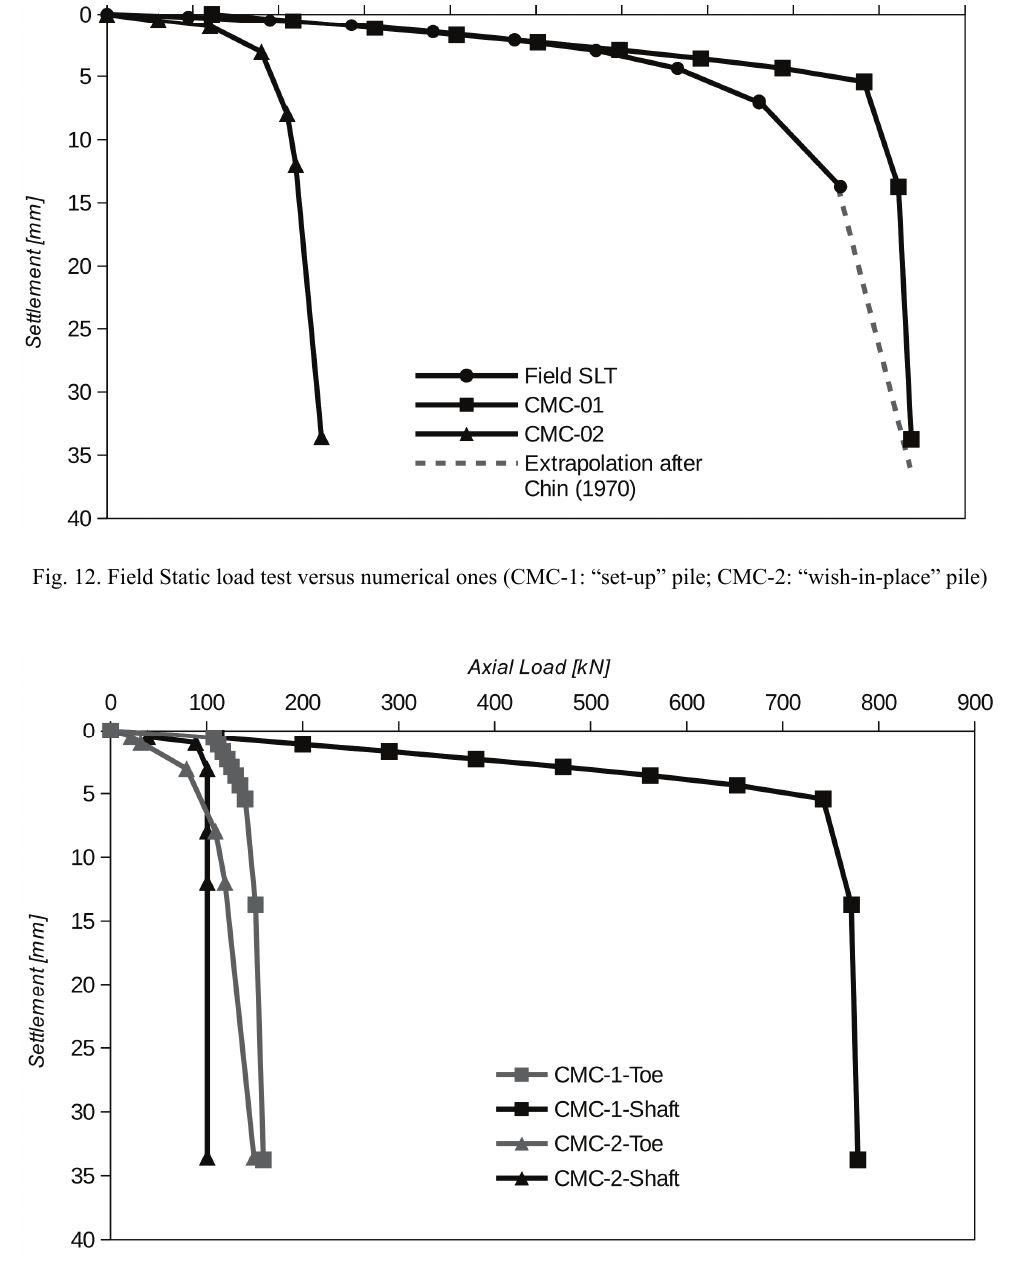
Fig. 13. Toe and shaft capacity obtained with CMC-1 and CMC-2 numerical